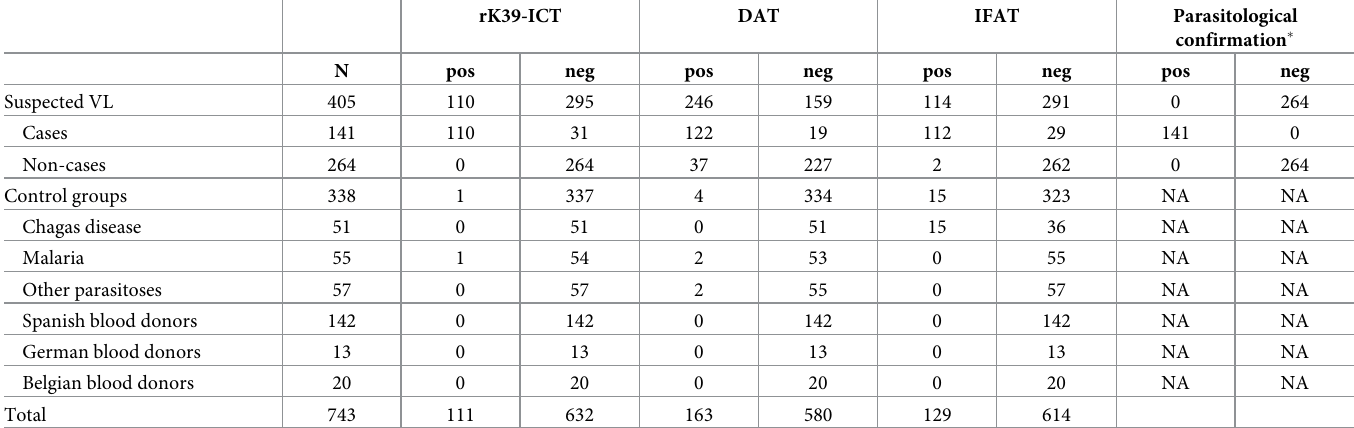
Table 1. Type and number of samples used in this study and diagnostic outcome from each test assessed.